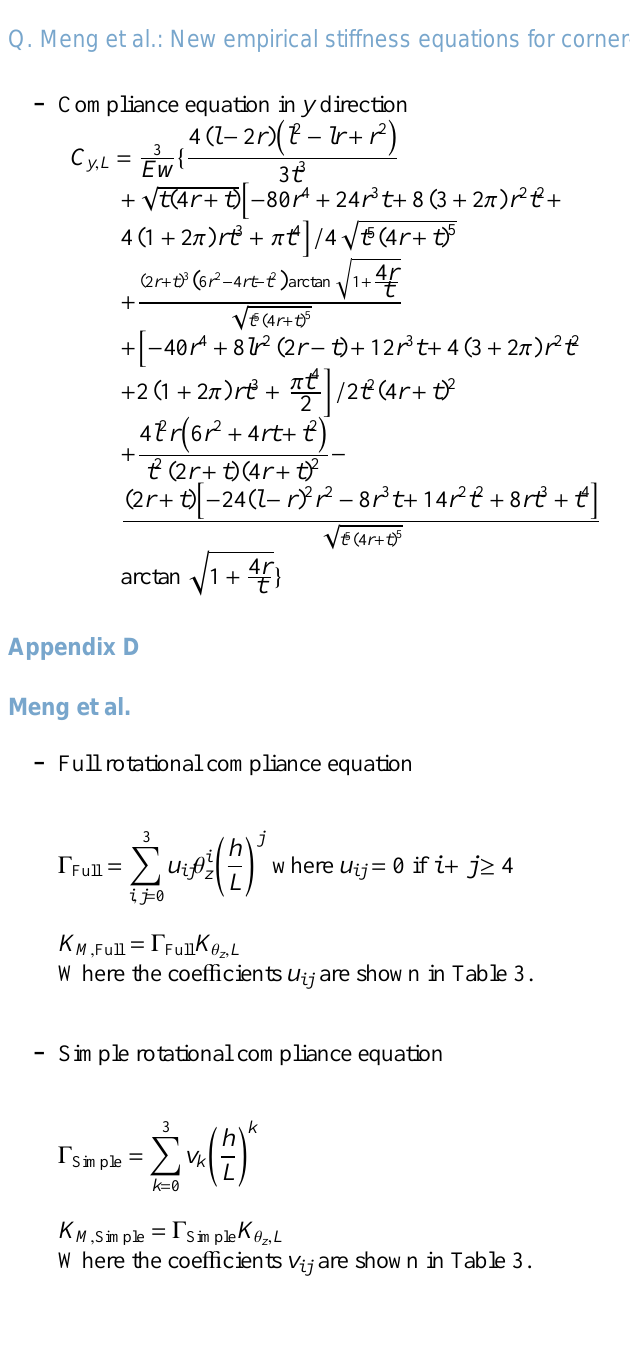
Table A1. Coe ffi cients for Full and Simple